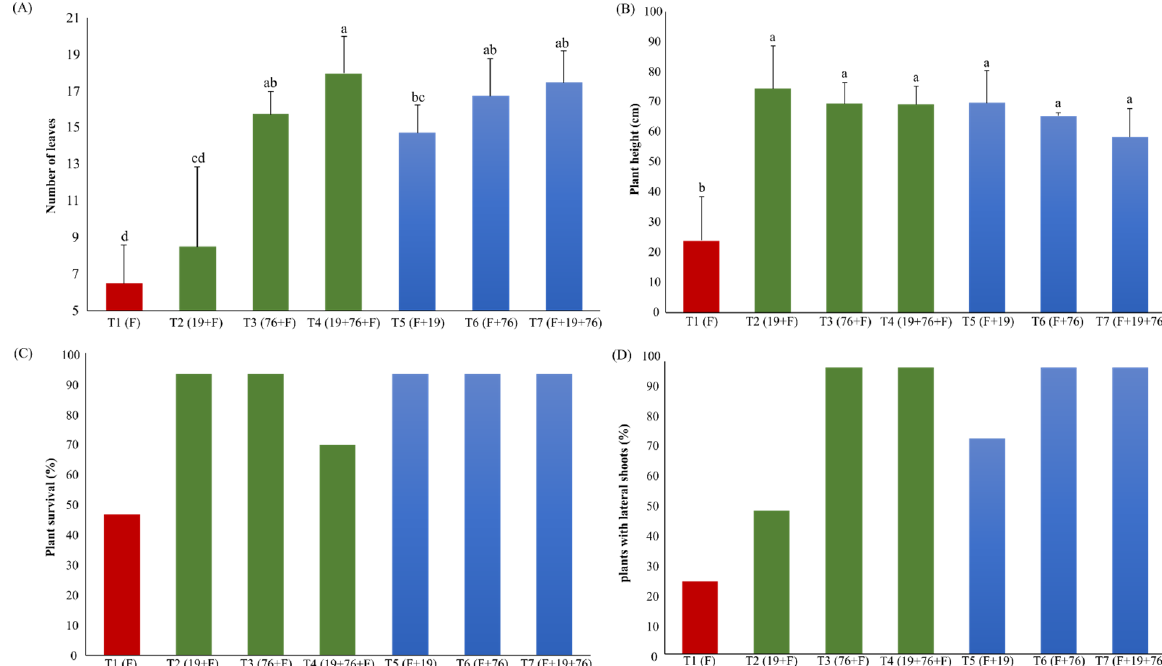
Figure 1. ( A ) Number of leaves in each plant (180 DAP); ( B ) plant height; ( C ) plant survival; ( D ) lateral shoot formation. F represents the inoculum with the fungus P. destruens , 19 represents the inoculum with the bacterium B. velezensis T149-19 and 76 represents the inoculum with the bacterium B. safensis T052-76. The position of letter F (before or after the numbers) indicates the moment of inoculation of the fungus (before or after bacteria). In ( A , B ), treatments that do not share a letter have a mean difference that is statistically significant based on the Mann–Whitney U test ( p <